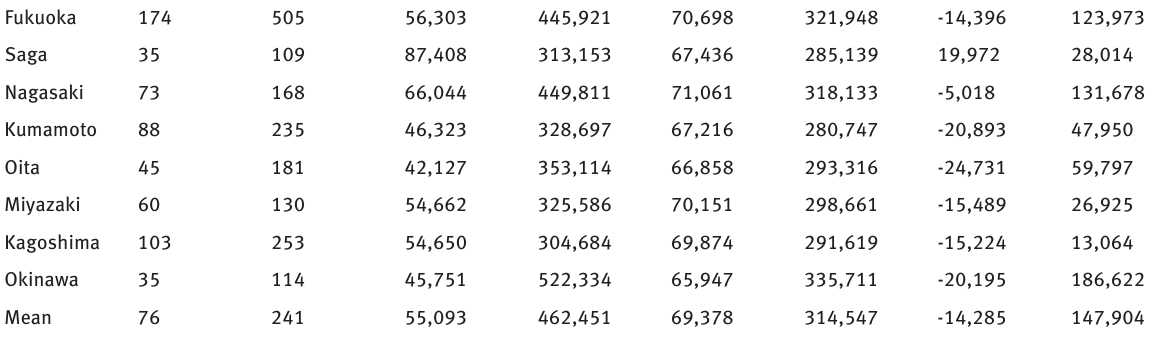
Table 6 continued: Annual net profits from CT in 47